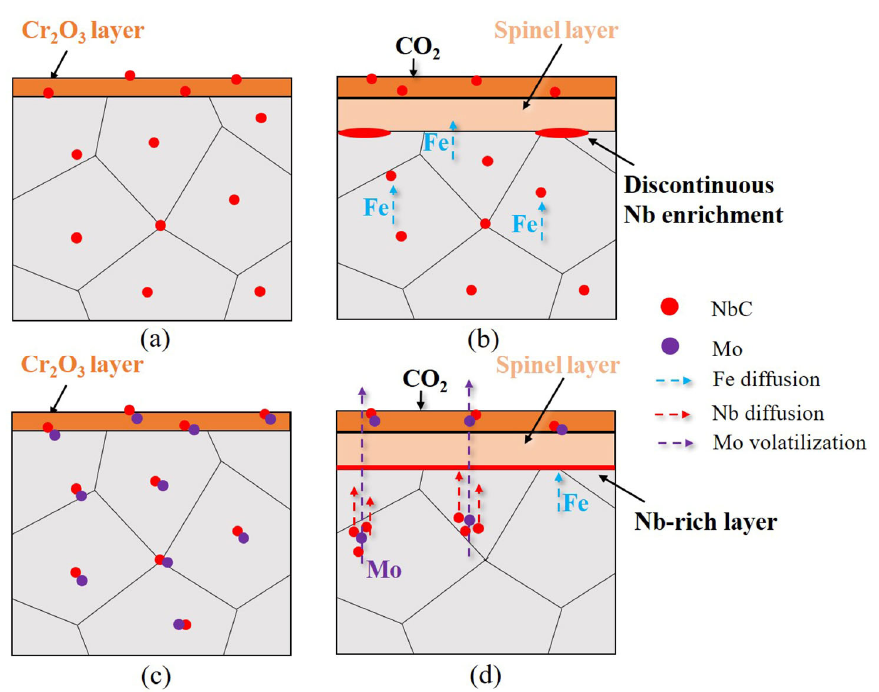
Figure 10. Schematic diagram of the formation process of oxide scales: ( a , b ) S2 and ( c , d )